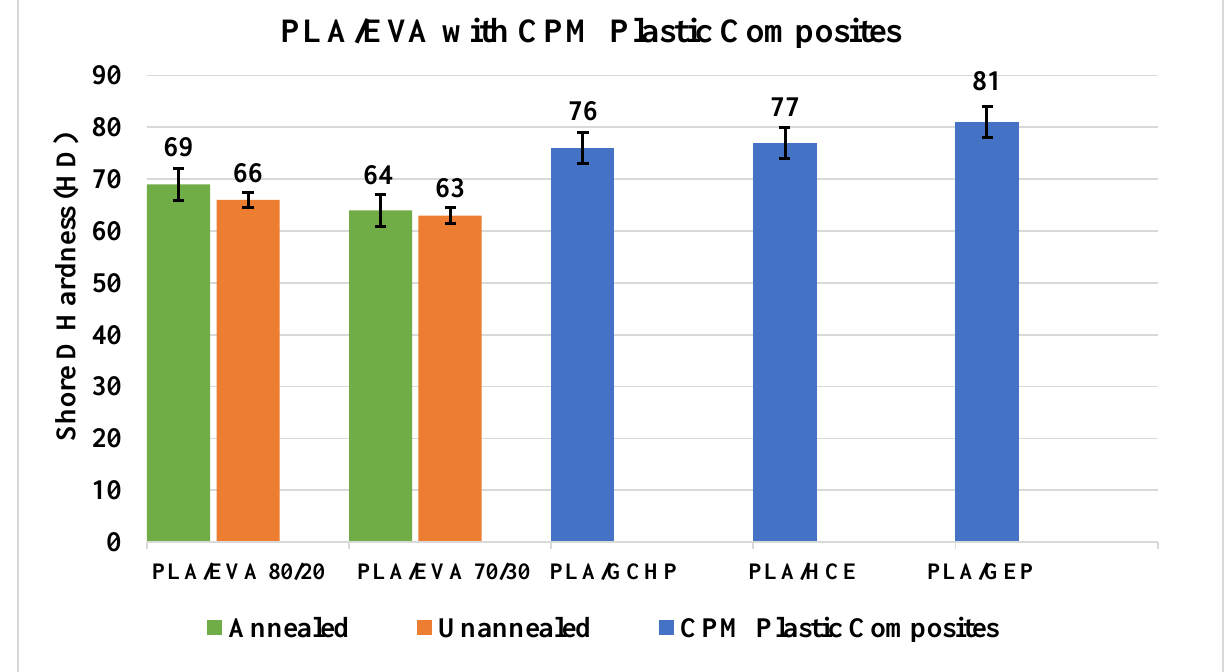
Figure 12. Results of PLA/EVA composites with CPM plastic composites.